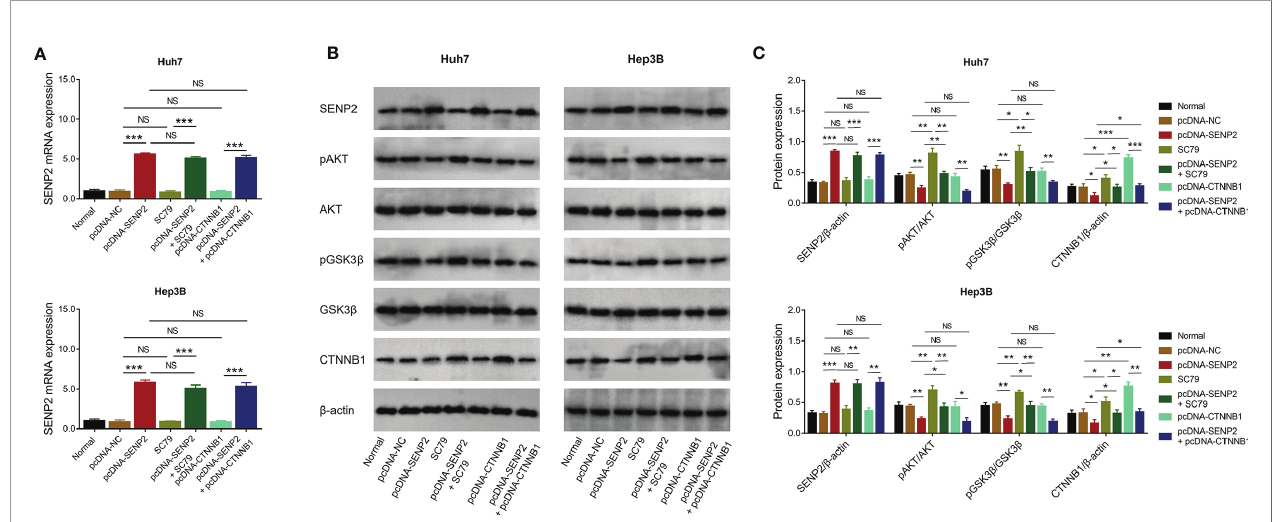
FIGURE 5 | Protein and mRNA expressions in the compensation experiment. Comparison of SENP2 mRNA expression among groups in Huh7 and Hep3B cells in the compensation experiment (A) . Detection of protein expressions by Western blot in Huh7 and Hep3B cells in the compensation experiment (B) . Comparison of SENP2, pAKT/AKT, pGSK3 b /GSK3 b , and CTNNB1 expressions among groups in Huh7 and Hep3B cells in the compensation experiment (C) . SENP2, Small ubiquitin-like modi fi er speci fi c peptidase 2; NC, negative control; AKT, protein kinase B; GSK3 b , glycogen synthase kinase-3 b ; CTNNB1, b -catenin; * p < 0.05; ** p < 0.01; *** p < 0.001; NS, not signi fi